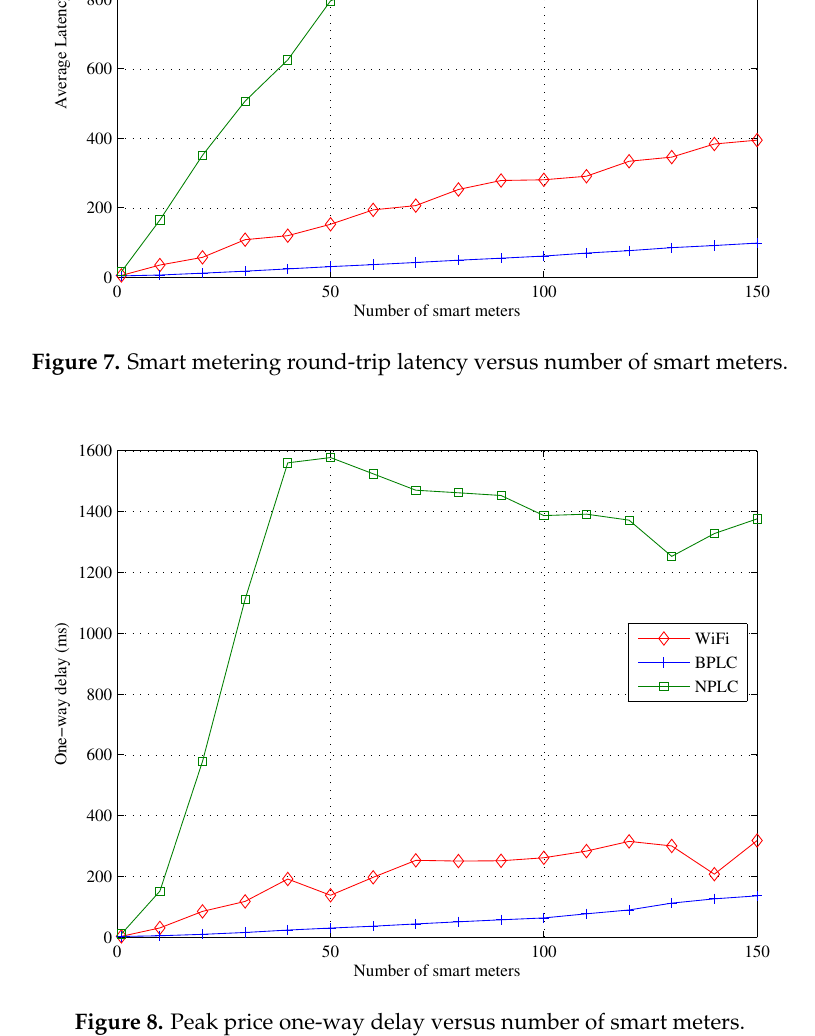
Figure 8. Peak price one-way delay versus number of smart